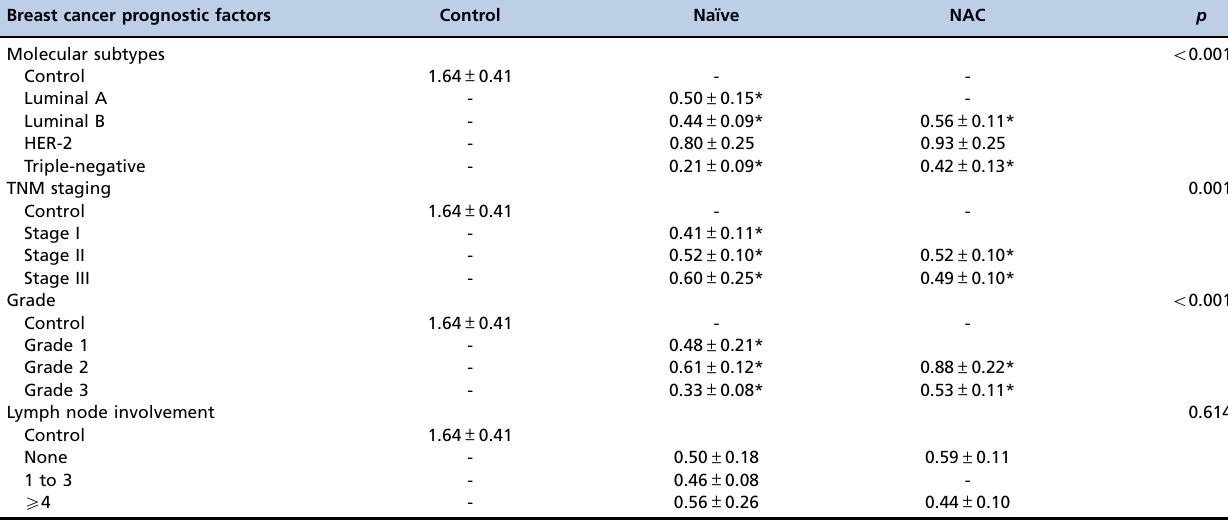
Table 3 - Prognostic factors and miRNA-195 expression in patients treated with neoadjuvant chemotherapy. Breast cancer prognostic factors Control Naı¨ve NAC p Molecular subtypes o 0.001